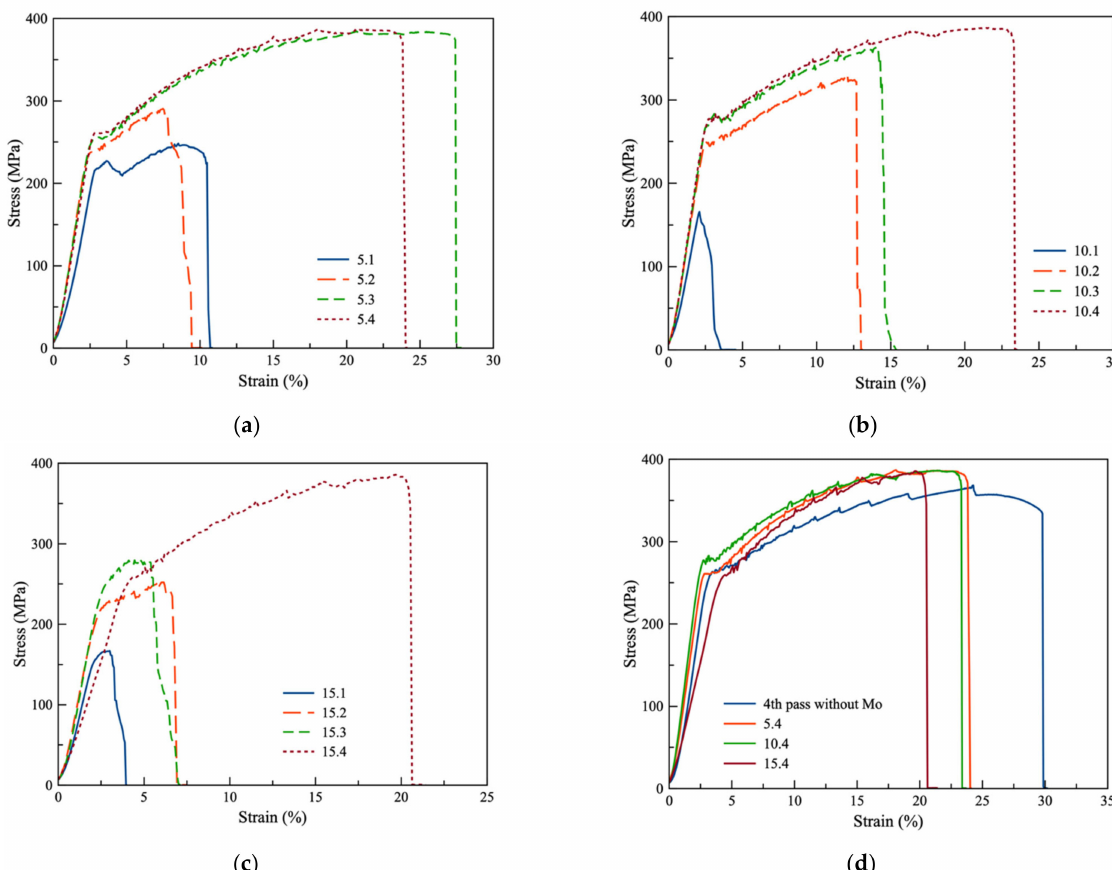
Figure 11. Static tensile test results of samples with 5 wt% Mo ( a ), 10 wt% Mo ( b ), and 15 wt% Mo ( c ), as well as a comparison of the stress–strain curves of the samples after four passes ( d ). As can be seen from Figure 11, four tool passes are minimum and sufficient in each case, except for 5 wt% Mo, in which high values of mechanical characteristics are already achieved on the third